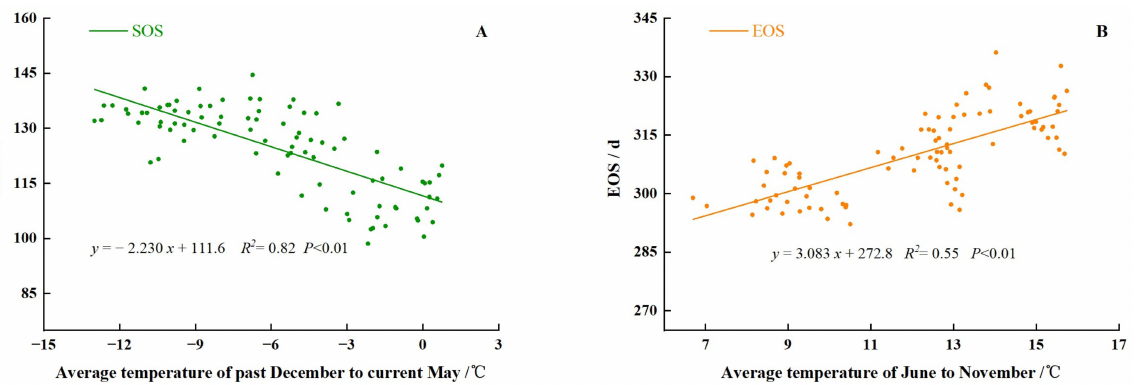
Figure 21. Responses of phenology to pre-season temperature in northeast China from 2011 to 2020. ( A ) is SOS; ( B ) is